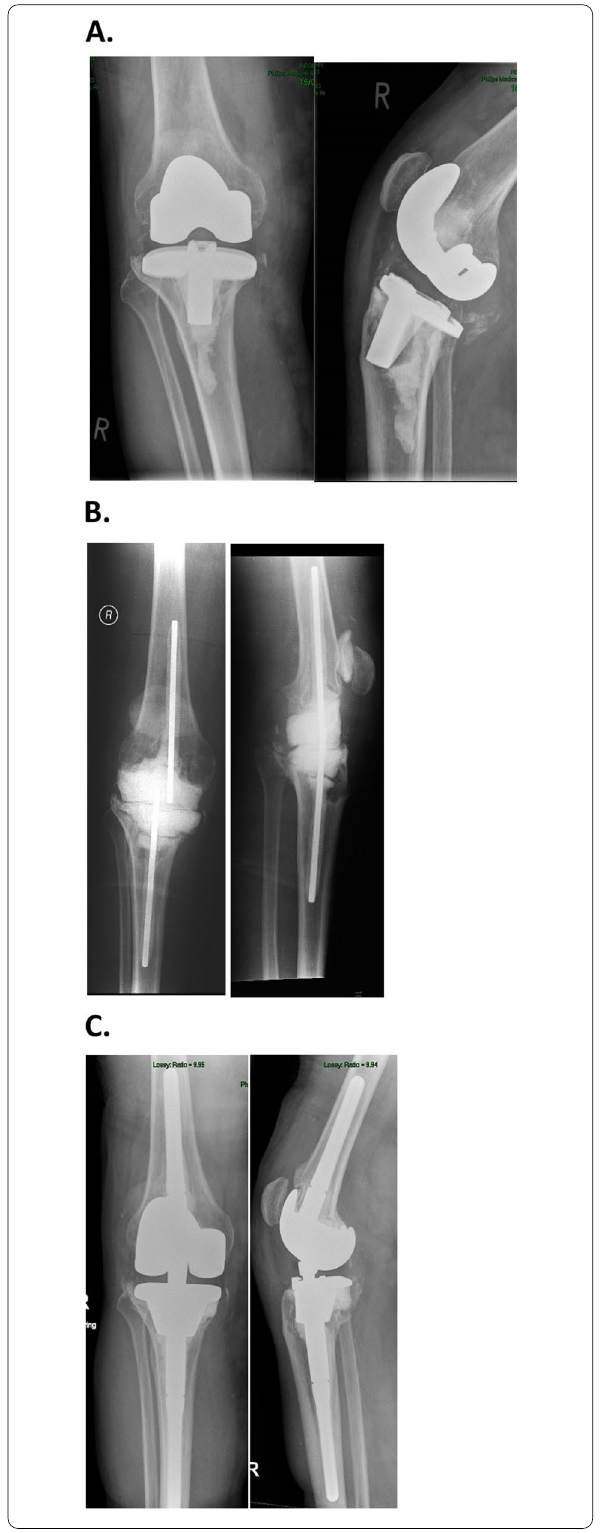
Fig. 3 Radiographs (a-p and lateral view) of a surgical case, right knee TKA after low grade infection with coagulase-negative Staphylococcus 2 years post-op with catastrophic implant failure ( a ), after implant removal and 1st stage static antibiotic cement spacer armed with IM femoral and tibial rods ( b ), and 2nd stage revision with tibial metal cone and rotating hinge revision implant, 3 years post-op ( c